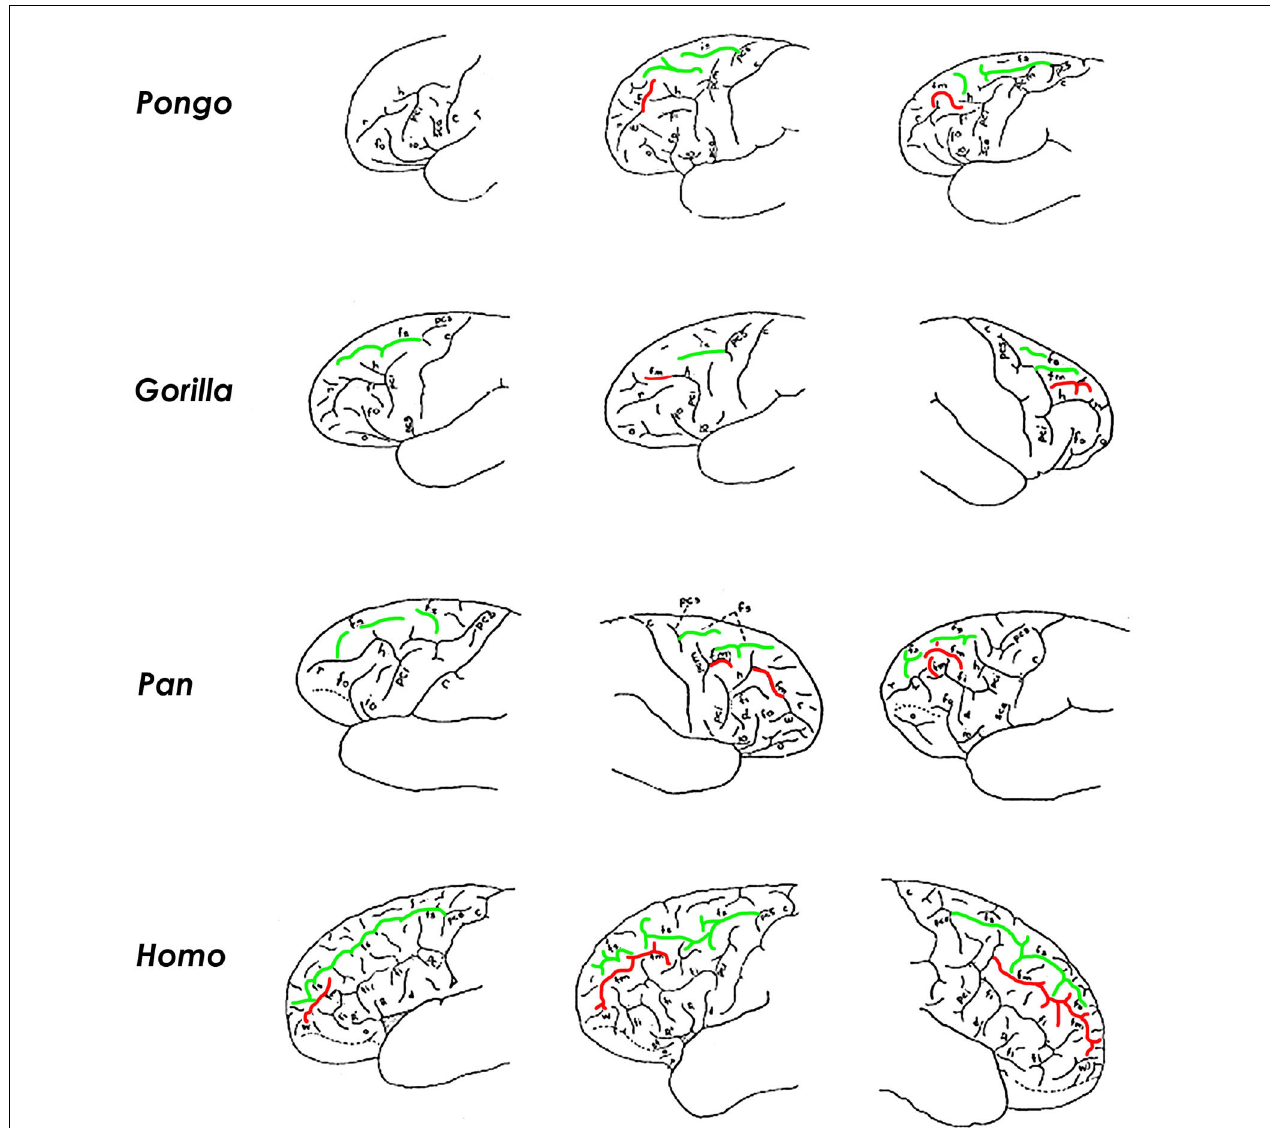
FIGURE 4 | The superior and middle frontal sulci in brains of great apes and humans. For each genus, illustrations are arranged from the simplest (left) to the most complicated (right) manifestation of fm (reddened). In the ∼ 20% of great ape hemispheres that have a separate fm , it is short and irregular in shape (right column). Human brains, on the other hand, usually have a separate elongated fm that courses parallel and lateral to the superior frontal sulcus ( fs , in green) (bottom row). According to Connolly, the caudal end of human fm emerged in conjunction with evolutionary expansion of prefrontal association cortex (i.e., it is a phylogenetically new portion of fm ).